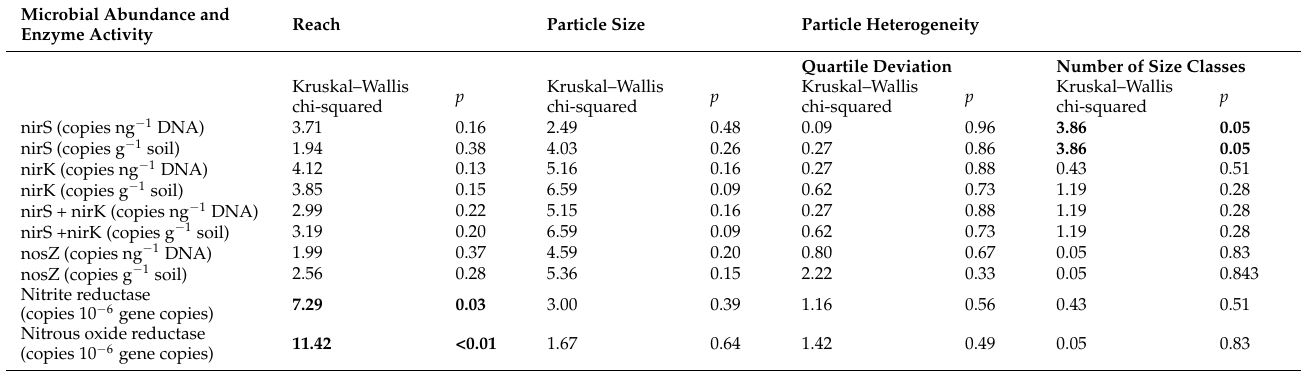
Table 3. Different denitrification gene abundances and enzyme activities under different particle sizes and heterogeneities and reaches as illustrated by the Kruskal–Wallis test. Values in bold indicate significant differences ( p < 0.05). Microbial Abundance and Enzyme